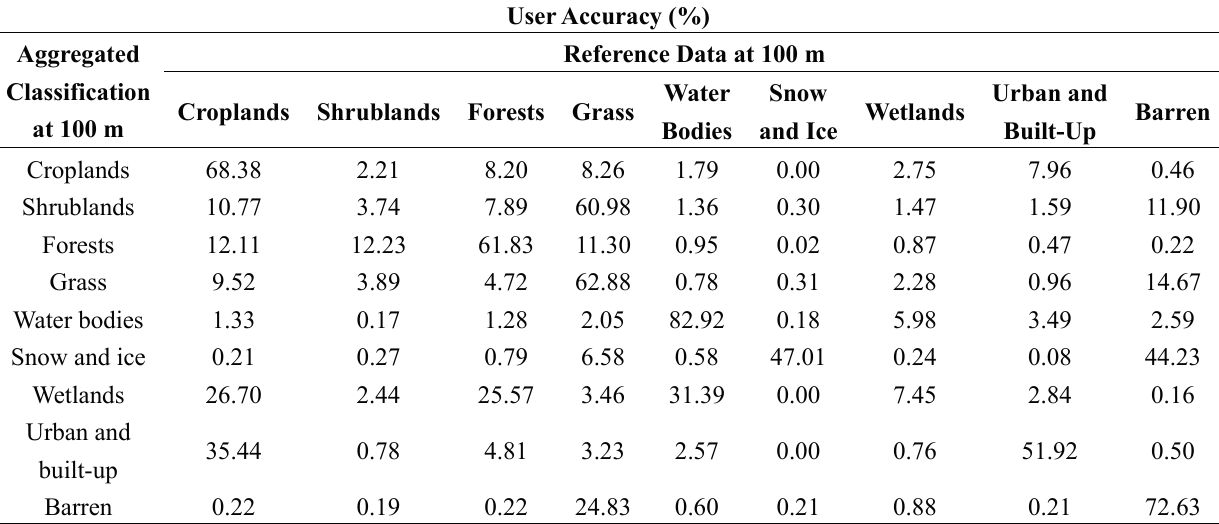
Table 3. Error matrix for aggregated classification at the sub-pixel